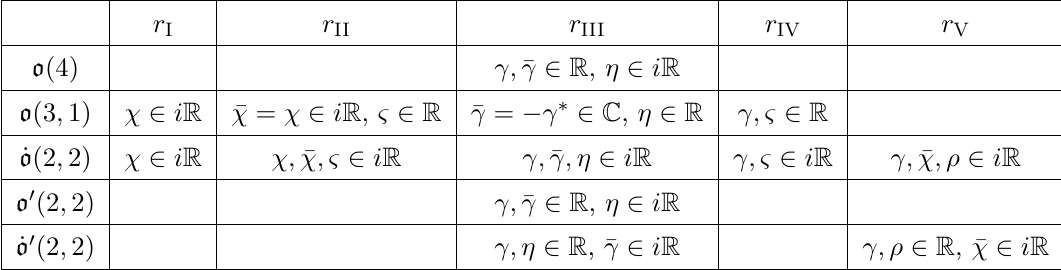
Table 1 . The families of r -matrices allowed for (pseudo-)orthogonal real forms of o (4; C ) [10]. For both o (4) and o (3 ; 1) it shows that J ing to the IW contraction chosen along the fourth axis and the spacetime metric (1 ; 1 ; 1 ; (cid:0) 1) in the latter